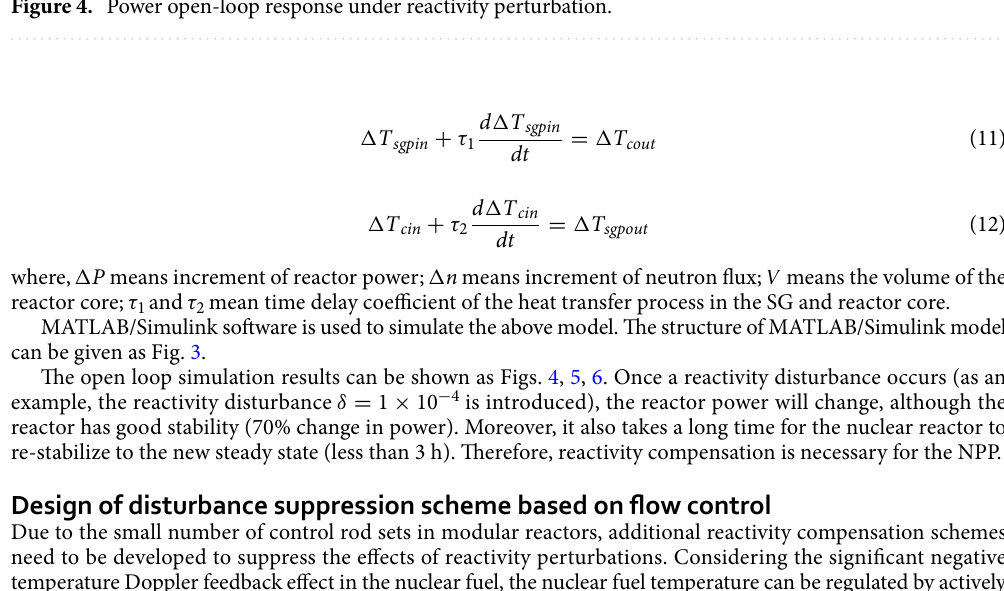
Figure 4. Power open-loop response under reactivity